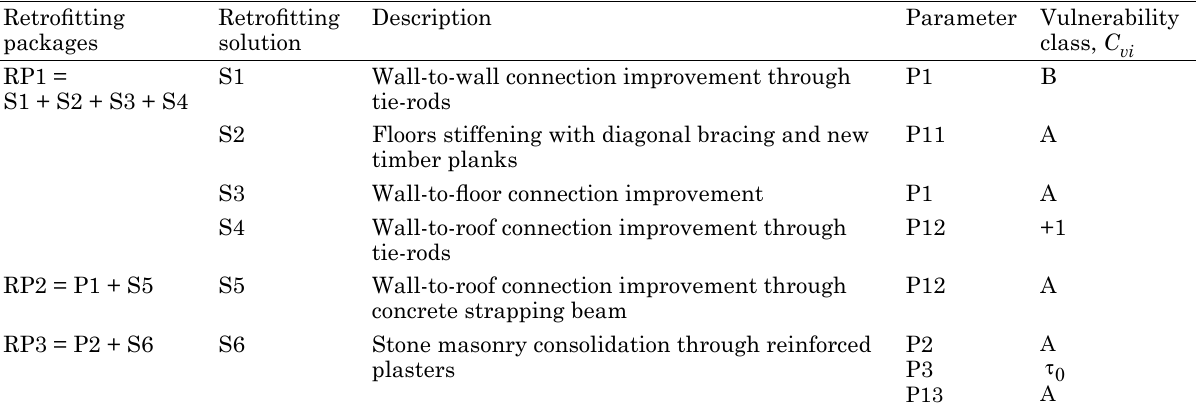
Table 3. influence of each retrofitting solution over the vulnerability index value, v I retrofitting